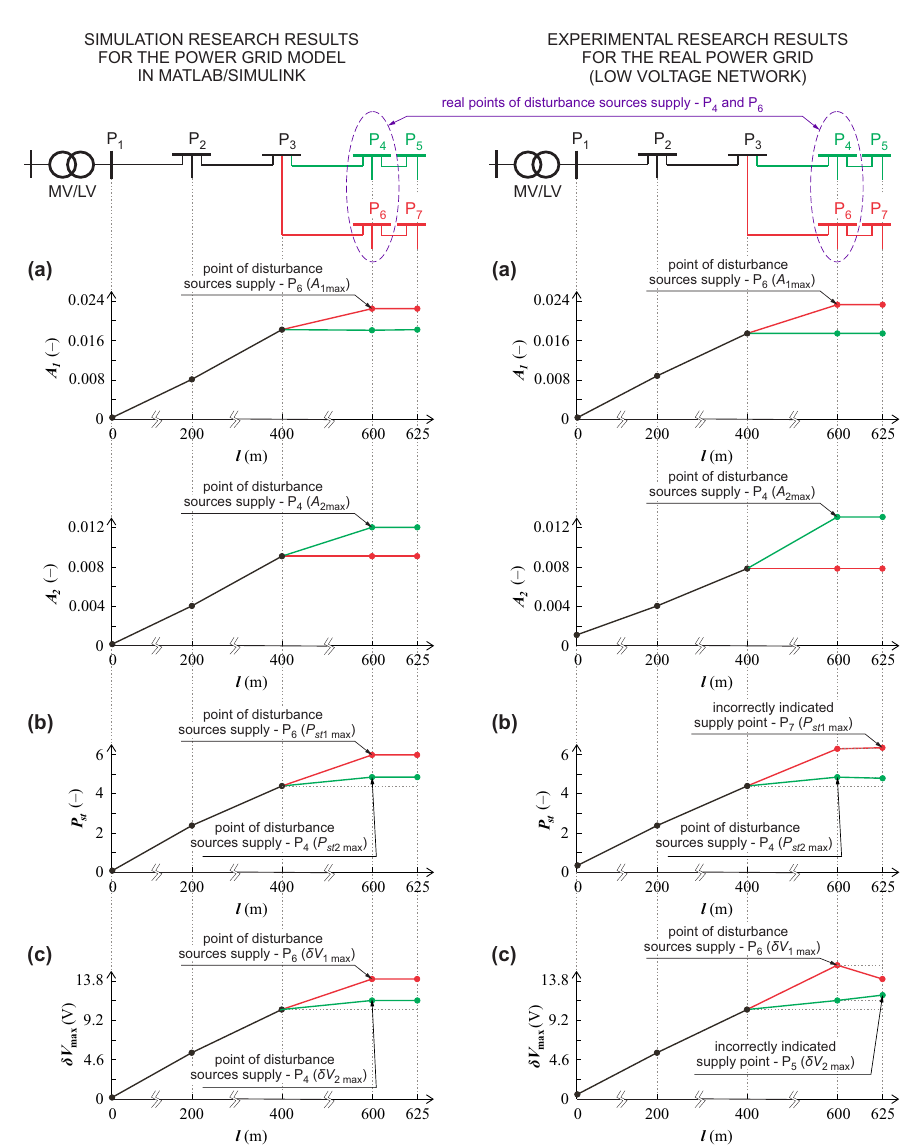
Figure 8. Comparison of the proposed approach (marked as ( a )) with other methods (the method using the statistical analysis of the rms value changes δ V marked as ( b ) and the method using the statistical analysis of the P st value marked as ( c )) for case I of Line 4 (simulation and experimental